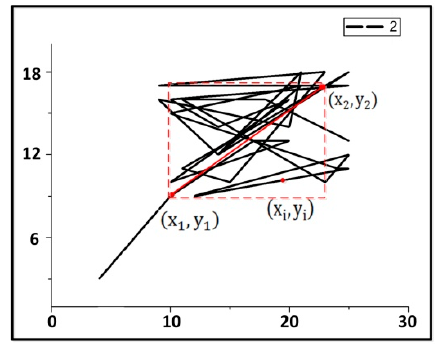
Figure 7. The rectangle trajectory and corresponding calculation.